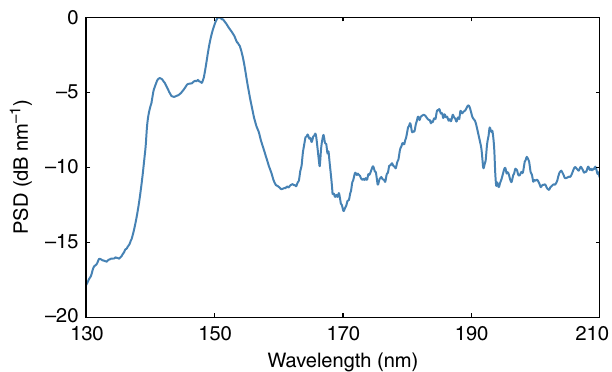
Fig. 2 Vacuum ultraviolet dispersive wave emission. Vacuum ultraviolet spectrum (intensity-calibrated) for 15 cm of an identical fi bre fi lled with 30 bar of neon, measured in a separate experiment at ~9 µ J input energy. The power spectral density (PSD) is normalized to the peak of the